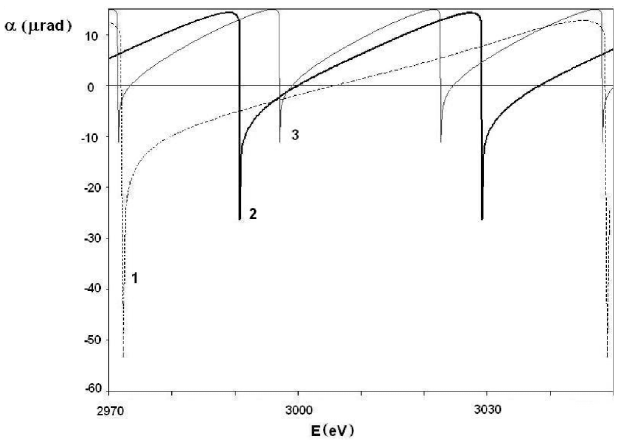
FIG. 6. Calculations of the volume reflection angle according (cid:2) =(cid:5) (cid:1)1(cid:2) as a function of the to Eq. (15). The relative value (cid:5) (cid:1) d vr 25 , 10, and 5